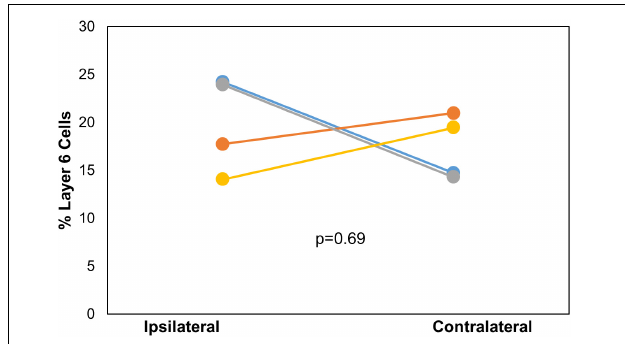
FIGURE 2 | Comparison of the layer 6 percent of total cells located ipsilaterally and contralaterally of the lemniscal AC between each mouse ( n = 4) with injection site in DC. p -value calculated using Wilcoxon Signed Rank Test. See Table 1 for actual values. n = 4 mice. Each color corresponds to a different mouse.